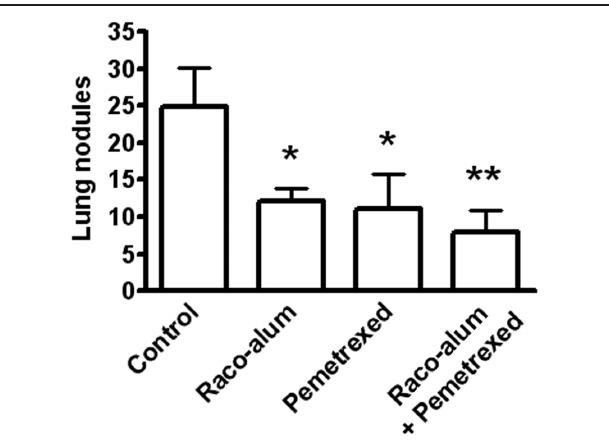
FIGURE 2 | Effects of racotumomab-alum immunization and chemotherapy on spontaneous lung nodule formation. Mice were inoculated subcutaneously with 3LL cells, and then immunized with racotumomab-alum (raco-alum) at 50 μ g/dose and/or administered with pemetrexed (100mg/kg), as described in “Materials and Methods.” Data were pooled from two independent experiments with similar results. Results are shown as mean ± SEM. ∗ p < 0 . 05, control versus raco-alum or versus pemetrexed; ∗∗ p < 0 . 01, control versus raco-alum plus pemetrexed (ANOVA followed by Bonferroni’s multiple comparison